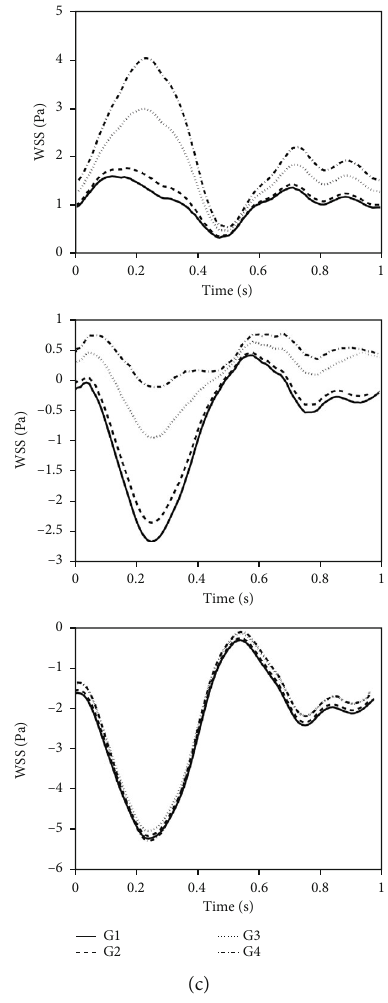
Figure 5: Wall shear stress at (a) proximal, (b) apex, and (c) distal of the stenosis. The beginning and the end points of the stenosis pro fi le were taken as proximal and distal points. Peak of the stenosis pro fi le was selected as the